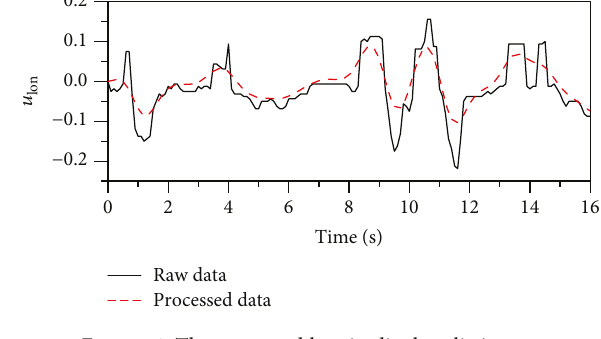
Figure 4: The processed longitudinal cyclic input. Table 2: Directly measured physical parameters of the Trex-600.